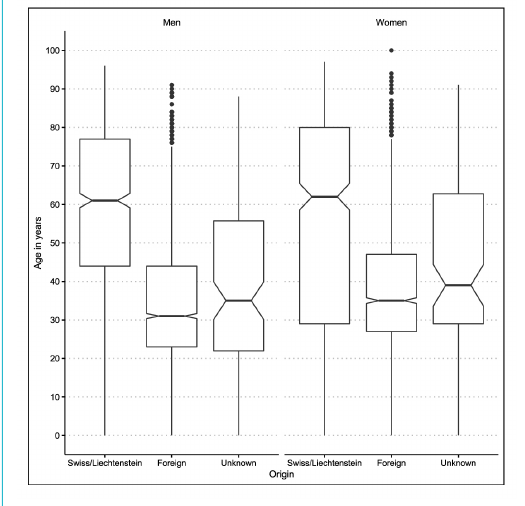
Figure 3: Age distribution, by sex and origin, of tuberculosis cases in Switzerland and Liechtenstein,